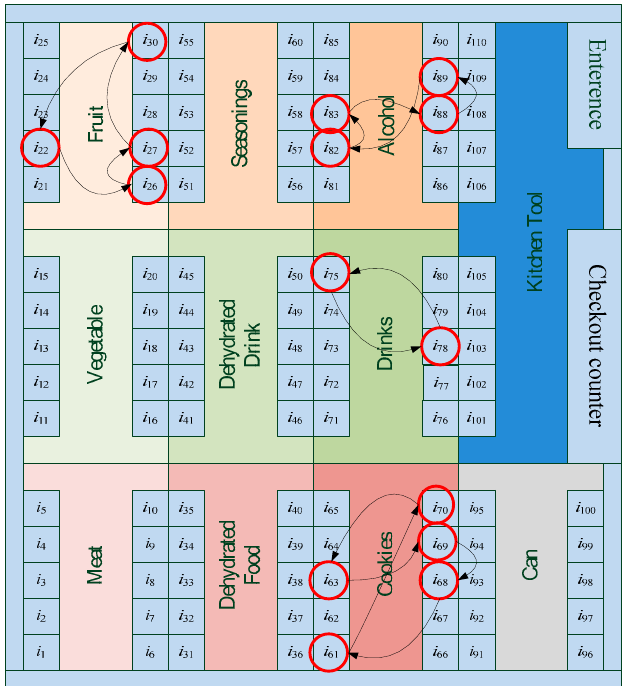
Figure 6. Fifteen re-shelved opportunity items.